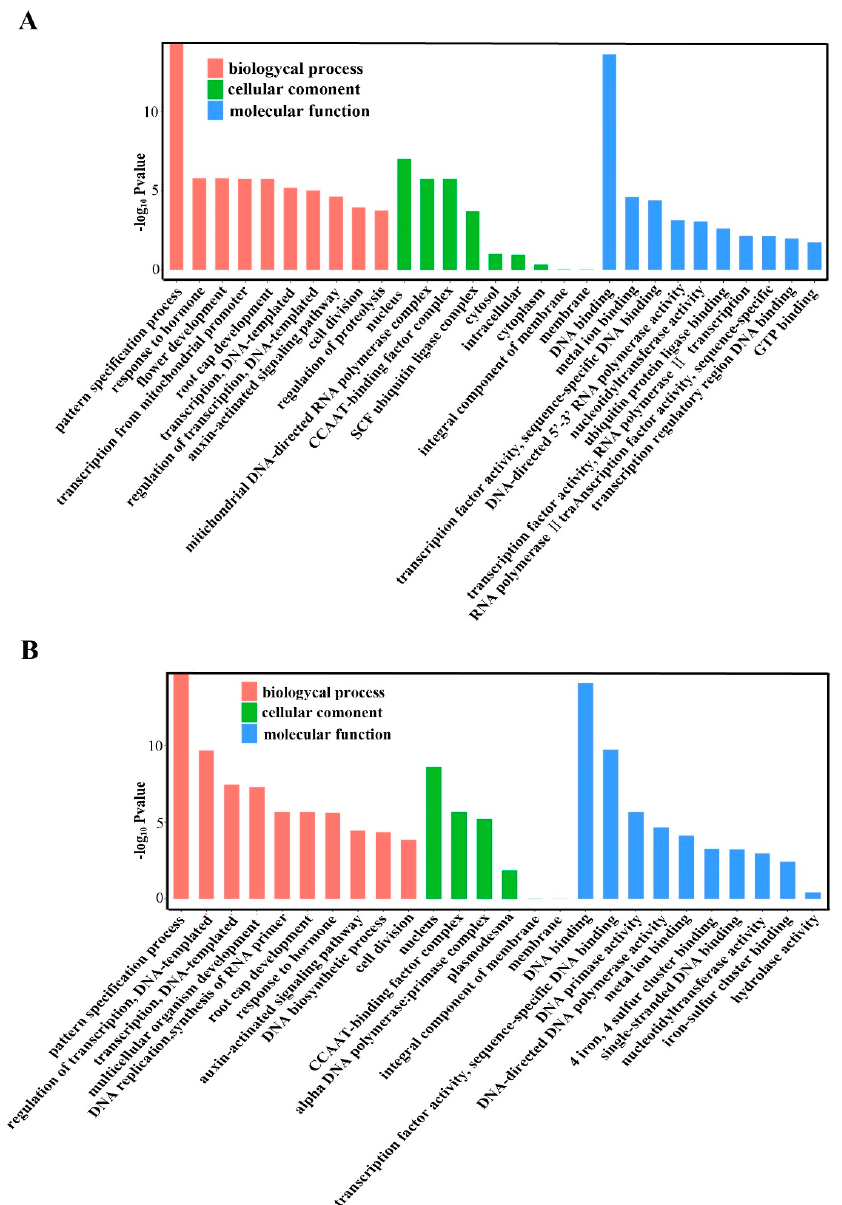
Figure 8. Gene ontology categories of the predicted target genes of the di ff erentially expressed miRNAs in grape. ( A ) Gene ontology categories of the predicted target genes of di ff erentially expressed miRNAs between RR-1 and CK-1. ( B ) Gene ontology categories of the predicted target genes of di ff erentially expressed miRNAs between RR-2 and CK-2.